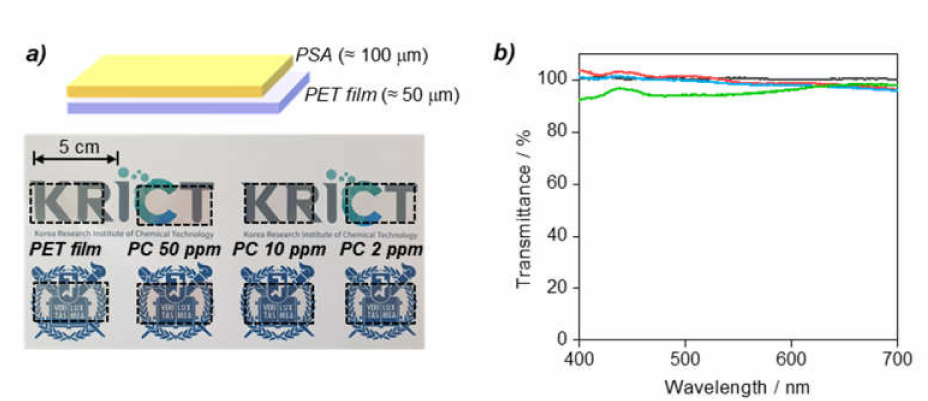
Figure 3. Transparency of the cured acrylic pressure-sensitive adhesive (PSA): ( a ) vertical structure (top) and transparency (bottom) of the PSA. ( b ) UV–Vis spectrum of the PSA obtained at a diethyl 2-bromo-2-methylmalonate concentration of 0.1 mol%. The gray, red, sky blue, and green lines represent the support polyethylene terephthalate (PET) film without a PSA layer and PSA films prepared using 2,4,5,6-tetrakis(diphenylamino)-1,3-benzenedicarbonitrile (4DP-IPN) loadings of 2, 10, and 50 ppm, respectively. The curing time was 30 min for all samples, except for the PSA prepared at a 4DP-IPN loading of 2 ppm, which was cured for 2 h for sufficient conversion.